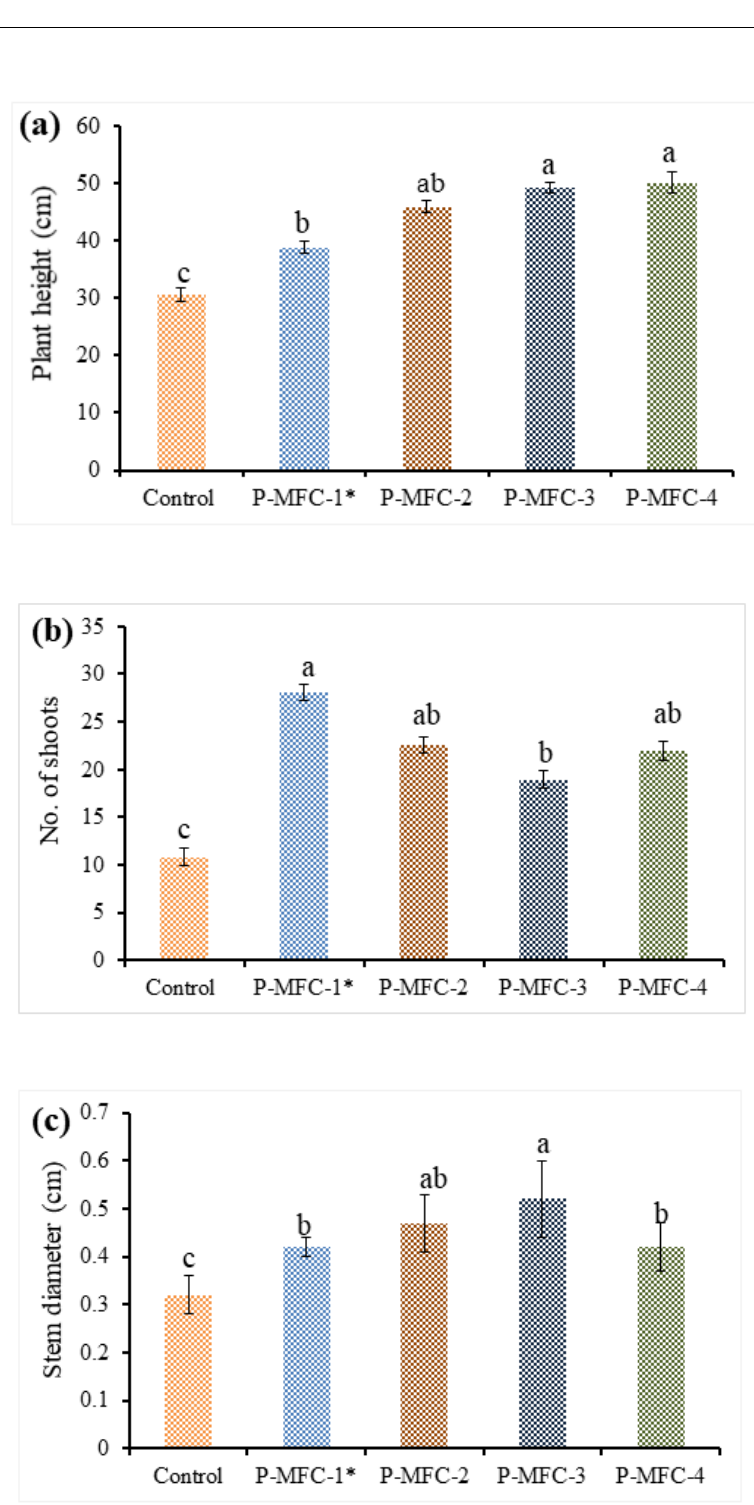
Figure 1. Effect of P-MFC on Stevia rebaudiana growth parameters: ( a ) plant height (cm); ( b ) number of shoots; ( c ) stem diameter (cm). Means with the same letter for each figure is statistically equal (Tukey, p < 0.05).